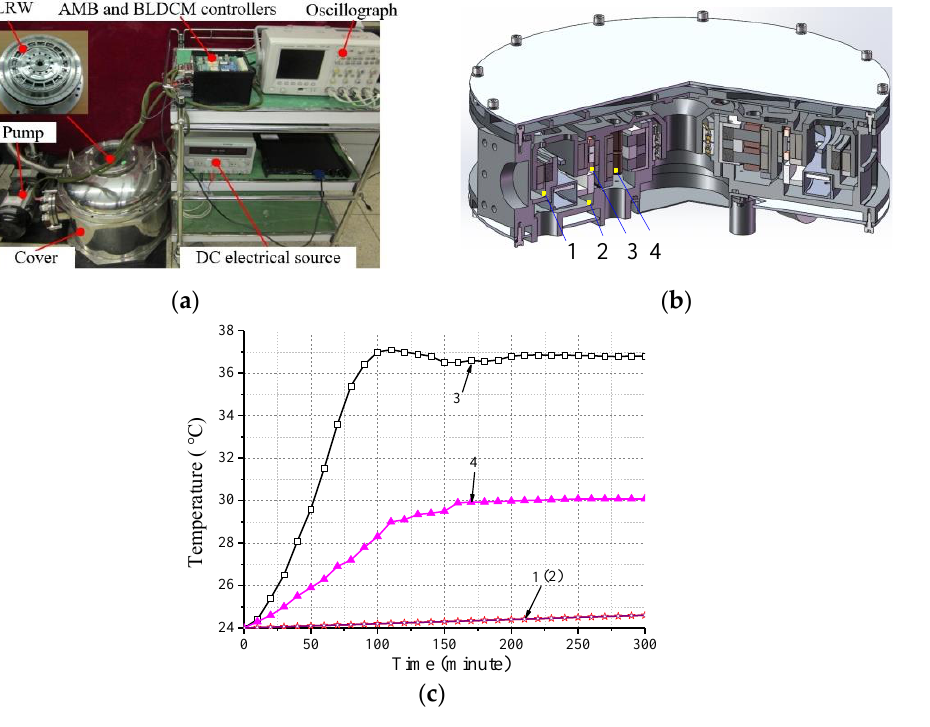
Figure 21. The testing setup of the MLRW prototype. ( a ) Testing setup. ( b ) Positions of the four thermistors. ( c ) Measurement data.